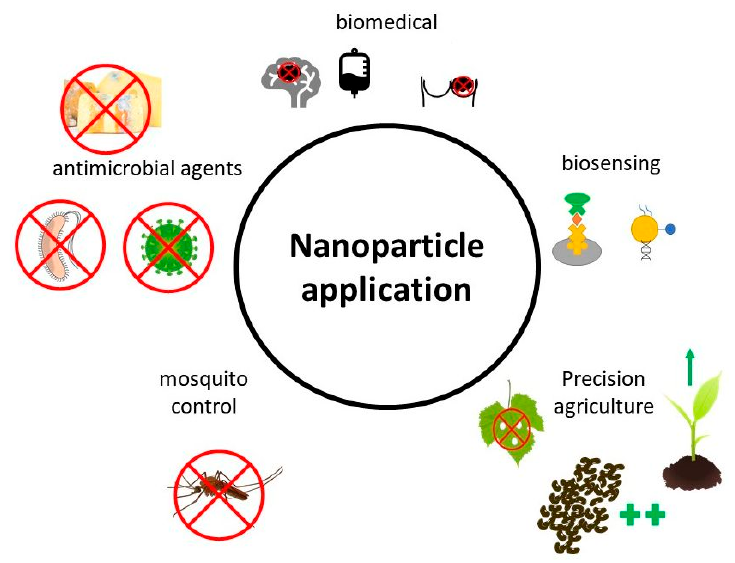
Figure 3. Different applications of metal-containing NPs created by mycosynthesis.